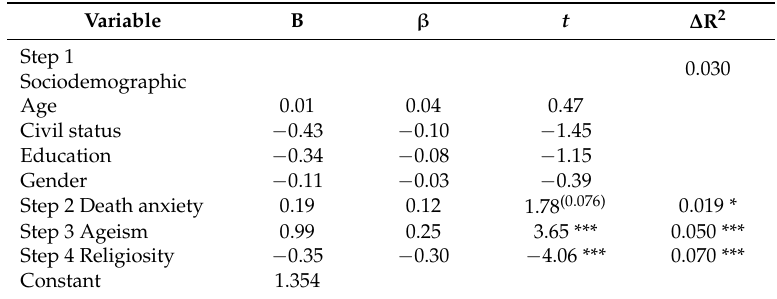
Table 3. Regression analysis of overall model for variables predicting the wish for PAS (N =